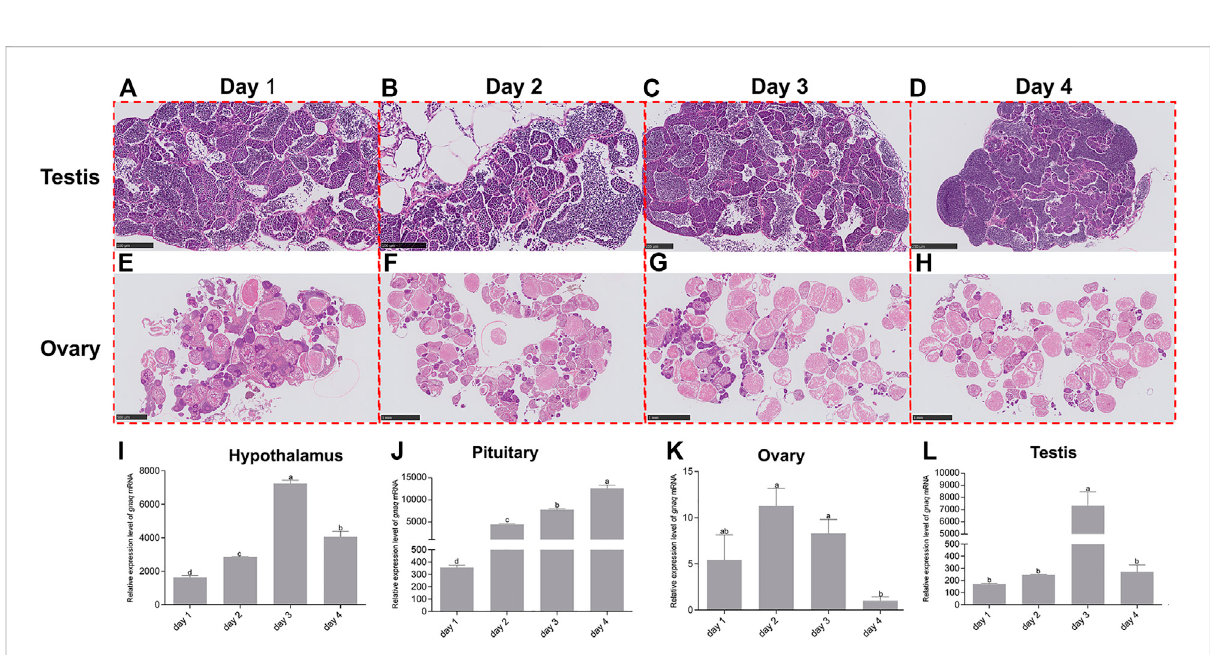
FIGURE 5 Dynamicchangesof gnaq expressioninHPGaxisduringthereproductivecycle. (A) TestisonDay1ofthereproductioncycle;scalebar:100 μ m; (B) testis on Day 2 ofthe reproduction cycle; scalebar: 100 μ m; (C) testison Day 3of the reproduction cycle;scale bar: 100 μ m; (D) testis on Day4 of the reproduction cycle; scale bar: 250 μ m; (E) ovary on Day 1 of the reproduction cycle; scale bar: 500 μ m; (F) ovary on Day 2 of the reproduction cycle; scale bar: 1 nm; (G) ovary on Day 3 of the reproduction cycle; scale bar: 1 nm; (H) ovary on Day 4 of the reproduction cycle; scale bar: 1 nm; (I) expression pattern of gnaq mRNA in the hypothalamus during the reproductive cycle; (J) expression pattern of gnaq mRNA in pituitary during the reproductive cycle; (K) expression pattern of gnaq mRNA in ovary during the reproductive cycle; (L) expression pattern of gnaq mRNA in testis during the reproductive cycle. Error bars indicate mean ± SEM ( n = 5); one-way ANOVA was used for statistical analysis ( p <